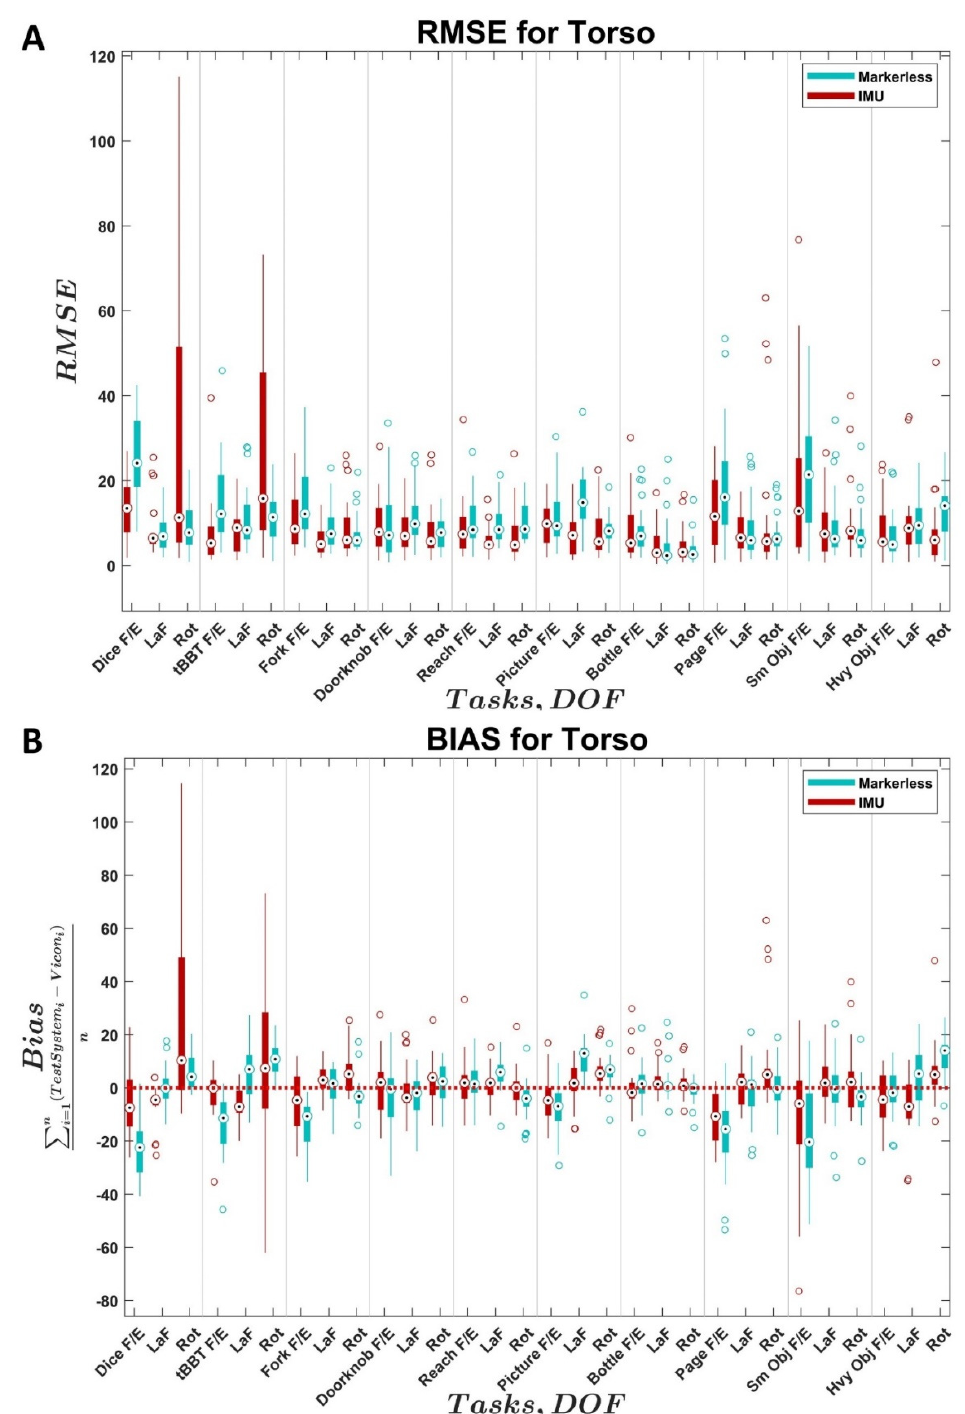
Figure 5. Distributions of ( A ) torso angle RMSE and ( B ) torso angle bias across subjects for the IMU system (Xsens Awinda MTw, El Segundo, CA) and markerless system (Kinect, Microsoft, Seattle, WA, USA) compared to the reference system (VICON, Oxford, UK). X-axis identifies the task and associated joint angle. F/E = flexion/extension, Ab/Ad = abduction/adduction, LaF = lateral flexion, Rot = rotation. Black dots indicate medians, empty circles indicate outliers, bold line indicates quartiles, and whiskers indicate non-outlier maximums and minimum.